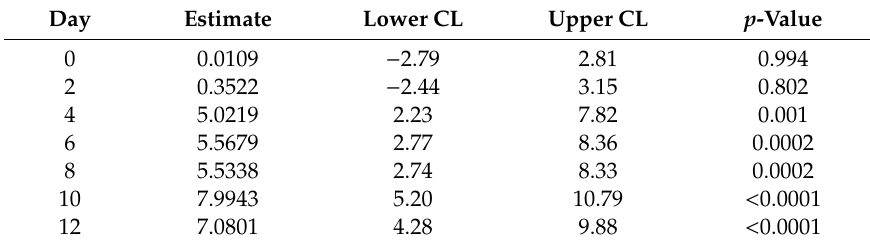
Table 2. Di ff erence between 0-dose and high-dose groups in least square means of PAX6 RNA expression according to day.